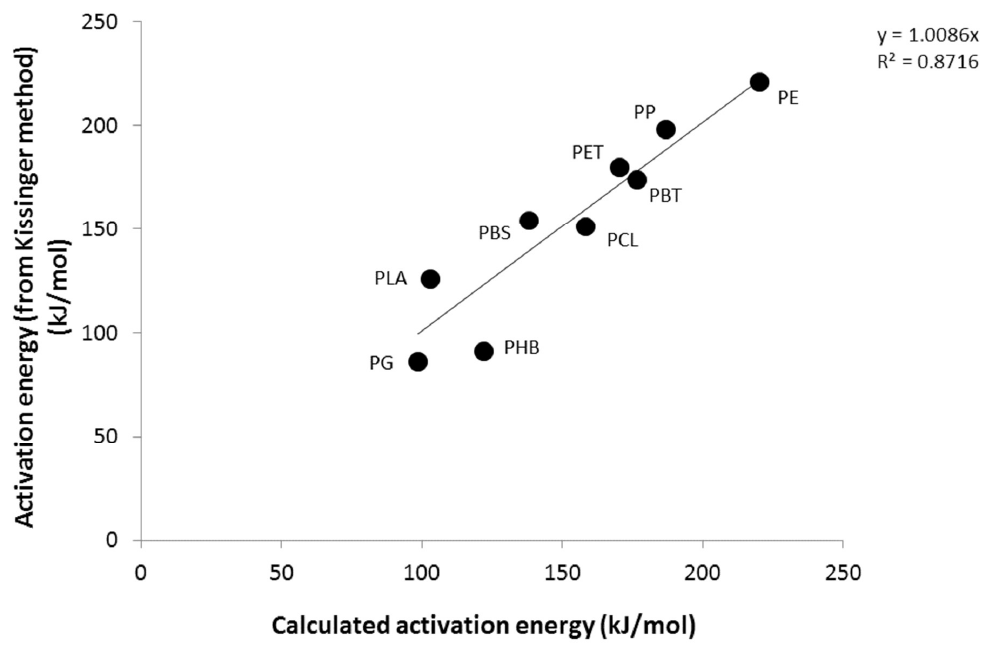
Figure 7. Experimental versus calculated LnA for the studied Figure 7 – Experimental versus calculated Ln(A) for the studied polymers